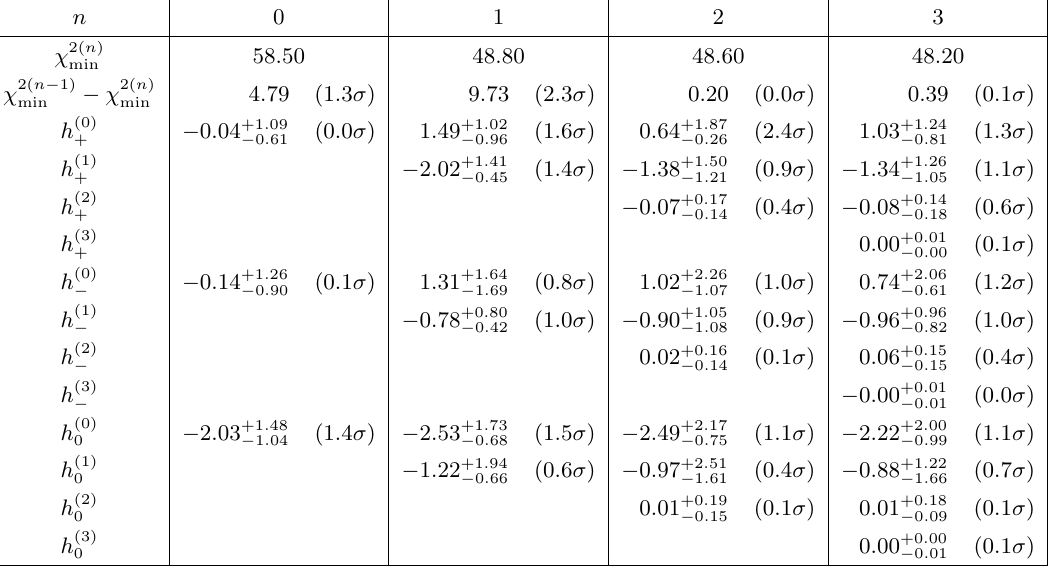
Table 4 . Fit to B ! K (cid:3) (cid:22) + (cid:22) (cid:0) only, with C (cid:22); NP